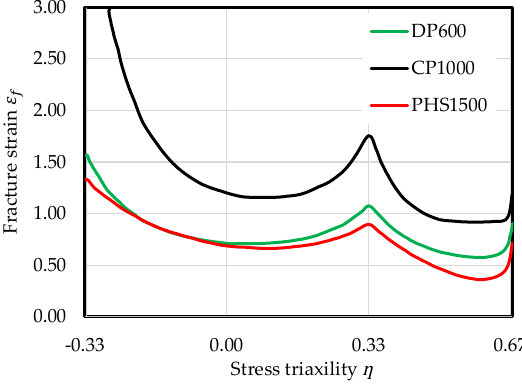
Figure 2. Fracture lines for DP600, CP1000 and PHS1500 [49].